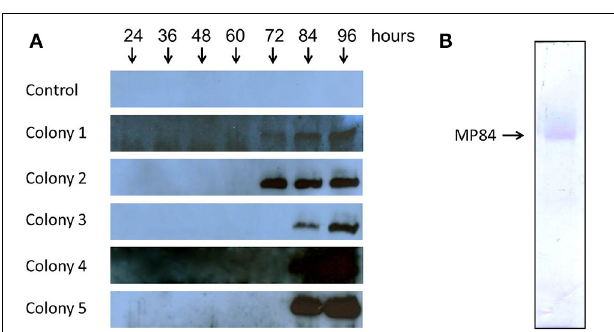
FIGURE 3 | Expression of MP84 mannoprotein in P. pastoris . P. pastoris was transformed with pPICZ α B-MP84 plasmid and positive colonies were selected in the presence of the drug. Expression tests were performed to choose colonies with high levels of expression. Colony 2 was selected with a high amount of protein secreted. MP84 was then purified from the culture supernatant by affinity chromatography with nickel columns. (A) Western Blot analysis of the recombinant MP84 expression of the indicated colonies with 24, 36, 48, 60, 72, 84, and 96 hours of growth. A colony with pPICZ α B without MP84 gene was used as negative control (Control). (B) SDS-PAGE of P. pastoris colony 2 culture supernatant after purification by affinity chromatography with nickel